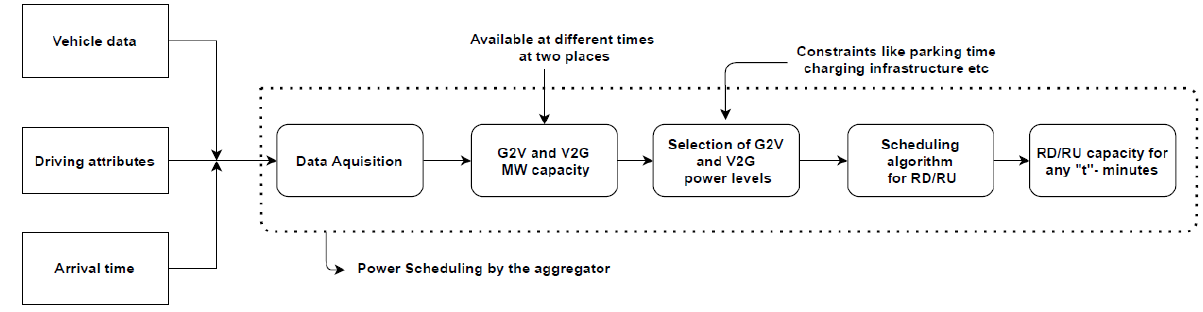
Figure 11. Schematic of the aggregator’s power scheduling activity for EV resource modelling.